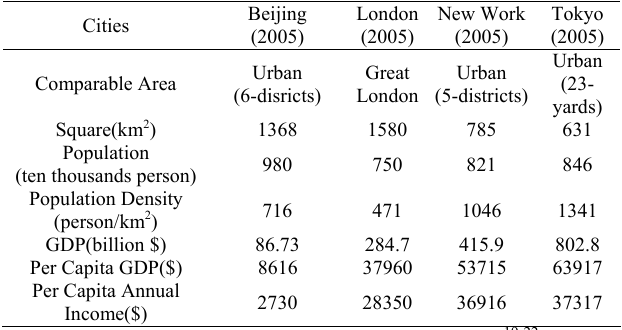
Table 1. Socio-economic index of the four